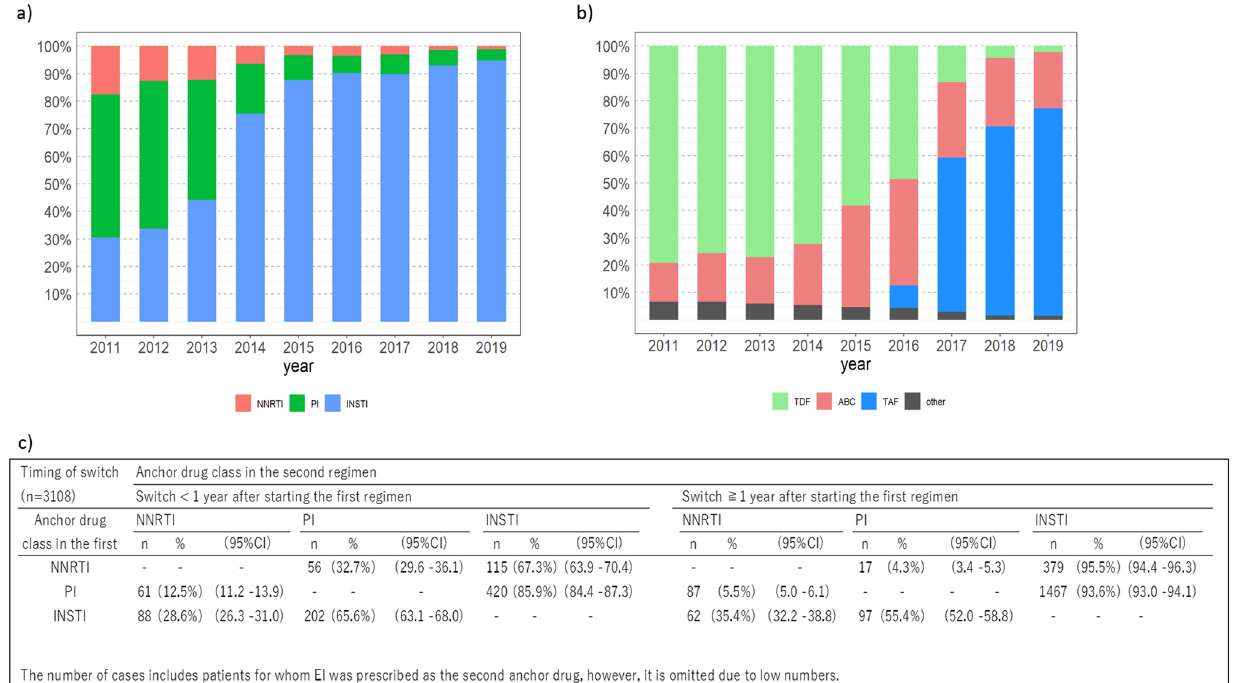
Figure 1. Distribution of ( a ) anchor and ( b ) backbone drug classes prescribed in first ART regimens by year (2011 ‒ 2019) (n = 16,069). ( c ) Timing and pattern of anchor drug class switching by duration after first ART regimen (n = 3108). Anchor drugs: NNRTI Non-nucleoside reverse transcriptase inhibitor, PI Protease inhibitor, INSTI integrase strand transfer inhibitor. Backbone drugs: ABC Abacavir, TDF Tenofovir disoproxil fumarate, TAF Tenofovir alafenamide, others include 3TC: lamivudine, FTC: emtricitabine. The years of launch of the anchor drugs by class were as follows: NNRTI: etravirine (launched in 2009) and rilpivirine (2012); PI: darunavir (2013); and INSTI: raltegravir (2008), dolutegravir (DTG) (2014), DTG/ABC/3TC (2015), and elvitegravir/cobi/TDF/FTC (2013). Patients prescribed an entry inhibitor in combination with others as a backbone were